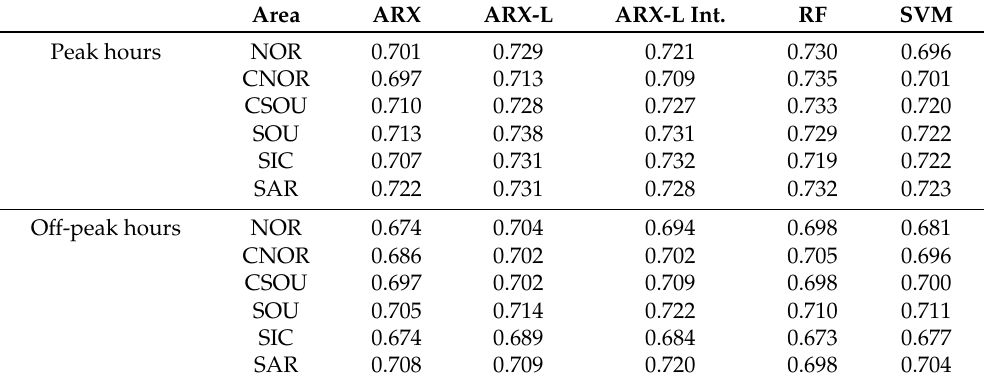
Table A1. Comparison of forecasting performances to those of the “Naive Week” RW model over peak (14 h) and off-peak (10 h) hours. Values are obtained as the ratio of the model’s average RMSE to the average RMSE under the “Naive Week” assumption, over the prediction horizon in the same hour group (peak and off-peak).